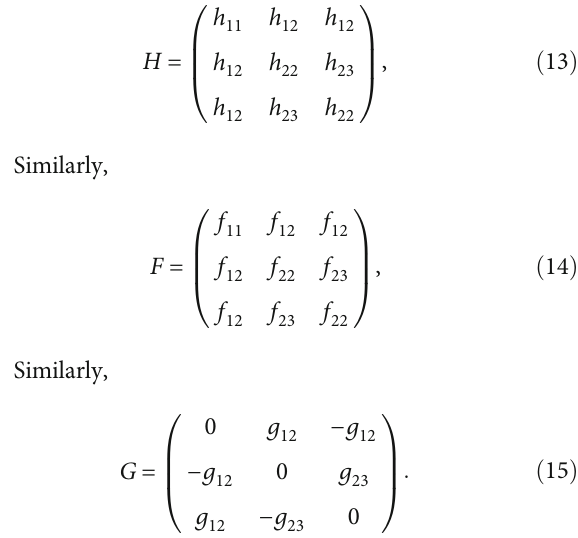
Figure 1: Predictions in the broken μ − τ symmetry model for normal ordering. (a) Predicted favoured values of the ð m best fi t values of δ = 222 ° with Δχ 2 = 6 : 2 w/o SK-ATM [14] (allowed by updated values of correct baryon asymmetry of the Universe) as a CP result of contribution of the type I seesaw mechanism to neutrino mass matrix. Similarly, (b) shows the predicted favoured values of the ð m Þ plane, for the best fi t value of θ , δ = 8 : 41 with Δχ 2 = 9 : 5 1 CP 13